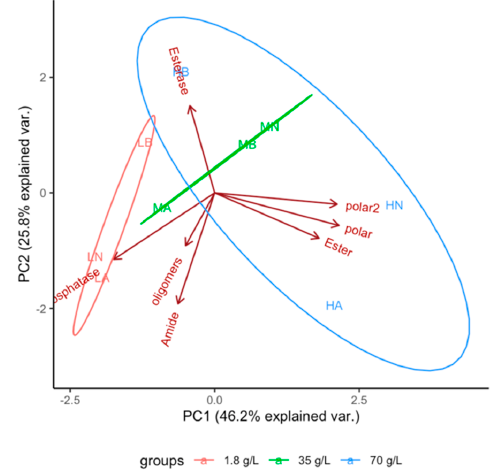
Figure 2. PCA biplot of evolved soups grouped by starting salinity. Low salinity (L, 1.8 g/L sea salt) is in red; medium salinity (M, 35 g/L sea salt) is in green; high salinity (H, 70 g/L sea salt) is in blue. Samples are also identified by acidic (A), neutral (N), or basic (B) labels within the graph. Brown arrows indicate the contribution by each chemical analysis measurement to components 1 and 2.